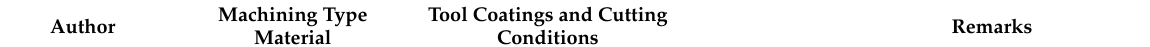
Table 12. Machinability performance during coated tools assisted machining of INCONEL ®